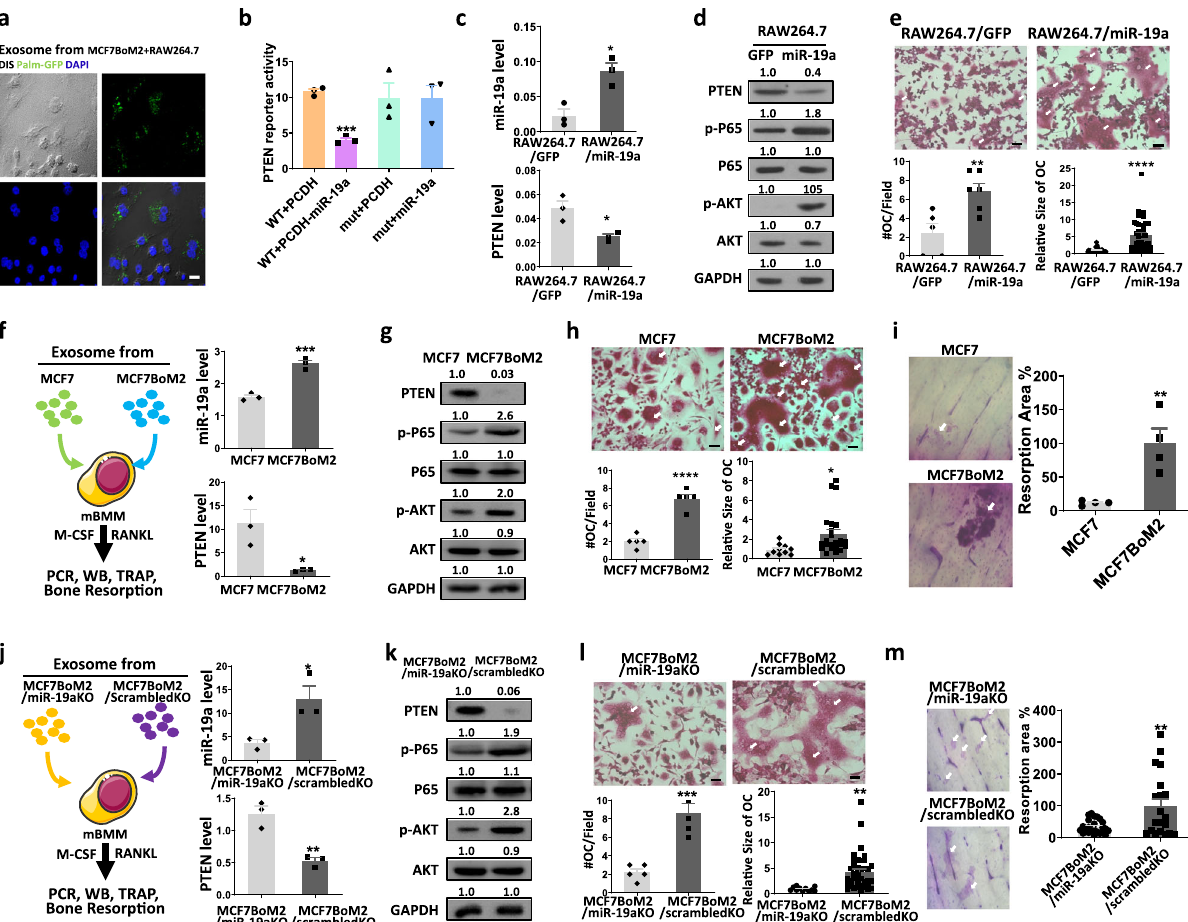
Fig. 4 Exosomal miR-19a targets PTEN/AKT pathway to promote osteoclastogenesis. a Exosomes were labeled with GFP by ectopic expression of PalmGFP in MCF7BoM2 cells. OC cells were then treated with the labeled exosomes. After 24 h, uptake of exosome by osteoclast cells was monitored by confocal microscope. Scale bar, 10 µ m. b Luciferase reporter assay for the constructs containing wild-type PTEN 3 ′ UTR or mutant PTEN 3 ′ UTR was performed after transfecting the cells with the miR-19a expression vector. p = 0.0001 (WT + PCDH vs WT + PCDH-miR-19a, two-sided student ’ s t -test). Data are presented as mean values ± SEM. c Taqman PCR for miR-19a expression ( p = 0.0131, n = 3), and SYBR Green qPCR for PTEN expression ( p = 0.0232, n = 3) in RAW264.7/GFP and RAW264.7/miR-19a were performed. Two-sided student ’ s t -tests were performed. Data are presented as mean values ± SEM. d Western blot analysis for PTEN, phospho-NF- κ B P65, total NF- κ B P65, phospho-AKT and total AKT expression in RAW264.7/GFP and RAW264.7/miR-19a cell lines. The band intensity was quanti fi ed and normalized to that of control (left panels). e TRAP staining of RAW264.7/GFP and RAW264.7/miR-19a cells. On day 4, the number of differentiated osteoclasts ( p = 0.0080, n = 5 vs 6) and the size of these cells ( p < 0.0001, n = 30 vs 40) were measured. Two-sided student ’ s t -tests were performed. Data are presented as mean values ± SEM. Scale bar, 100 µ m. f Mouse BMMs were induced into OC cells with the treatment of exosomes and cytokines. Taqman PCR for miR-19a expression ( p = 0.0008, n = 3) and SYBR Green qPCR for PTEN ( p = 0.0271, n = 3) expression were performed for OC cells treated with exosomes from MCF7 and MCF7BoM2. Two-sided student ’ s t -tests were performed. Data are presented as mean values± SEM. g Western blot analysis for PTEN, phospho-NF- κ B P65, total NF- κ B P65, phospho-AKT and total AKT expression in mouse BMMs treated with exosomes from MCF7 and MCF7BoM2. The band intensity was quanti fi ed and normalized to that of control (left panels). h TRAP staining was performed for mouse BMMs treated with exosomes from MCF7 and MCF7BoM2. On day 4, the number of differentiated osteoclast ( p = 0.000036, n = 5 vs 5) and their sizes ( p = 0.0323, n = 10 vs 23) were measured. Two-sided student ’ s t -tests were performed. Data are presented as mean values± SEM. Scale bar, 100 µ m. i Bone-resorbing activities of OC treated with exosomes from MCF7 and MCF7BoM2 were measured by the bone-resorption assay. BMMs were seeded on a bone chip and treated with exosomes and cytokines. Resorption pits were measured and compared ( p = 0.0070, n = 4). Two-sided student ’ s t -tests were performed. Data are presented as mean values± SEM. j Taqman PCR for miR-19a expression ( p = 0.0291, n = 3) and SYBR Green qPCR for PTEN expression ( p = 0.0047, n = 3) were performed for mouse BMMs treated with exosomes from MCF7BoM2/miR-19aKO and MCF7BoM2/ScrambledKO. Two-sided student ’ s t -tests were performed. Data are presented as mean values ± SEM. k Western blot analysis was performed for PTEN, phospho-NF- κ B P65, total NF- κ B P65, phospho-AKT, and total AKT expression in mouse BMMs treated with exosomes from MCF7BoM2/miR-19aKO and MCF7BoM2/ScrambledKO. The band intensity was quanti fi ed and normalized to that of control (left panels). l TRAP staining was performed for mouse BMMs that were treated with exosomes from MCF7BoM2/miR-19aKO and MCF7BoM2 /ScrambledKO. On day 4, the number of differentiated osteoclast cells ( p = 0.0005, n = 5 vs 5) and their sizes were measured ( p = 0.0029, n = 11 vs 38). Scale bar, 100 µ m. Two-sided student ’ s t -tests were performed. Data are presented as mean values ± SEM. m The bone-resorbing activity of OC was measured by the bone-resorption assay using BMMs that were treated with exosomes from MCF7BoM2/miR-19aKO and MCF7BoM2/ScrambledKO ( p = 0.0025, n = 24 vs 20). Two-sided student ’ s t -tests were performed. Data are presented as mean values ±